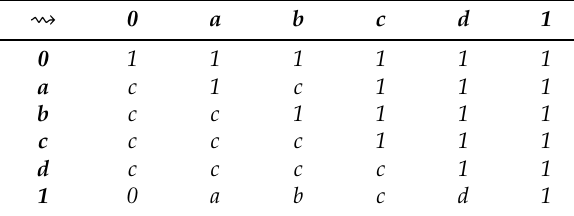
Table 10. The operation (cid:32) on X .